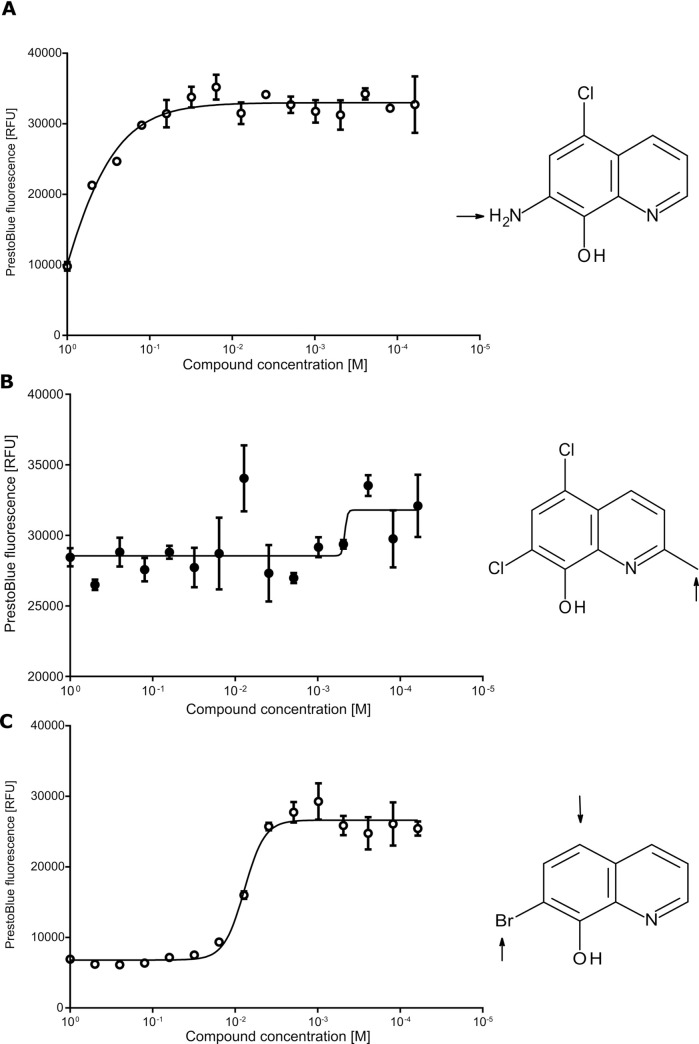
Hit expansion around chloroxine.A B. thailandensis culture was harvested and resuspended to a concentration of 8x108 CFU/mL in M9 media supplemented with 730 μM ceftazidime. This was added to a 96 well plate containing two-fold dilutions of compounds in DMSO from a starting concentration of 1 mM. Plates were incubated for 24 hours at 37°C before addition of the PrestoBlue cell viability reagent and the fluorescence read. Results show three biological replicates with error bars indicating standard deviation. These experiments are equivalent to those in Fig 3 and can be compared to chloroxine in Fig 3. 7-amino-5-chloro-8-quinolinol differs to chloroxine through substitution of an amino group for a chlorine at position 7 (A). This modification causes a significant decrease in this compound’s activity as a co-treatment with ceftazidime, with a pIC50 ≈ 3.4. 5,7-dichloro-2-methyl-8-quinolinol differs from chloroxine by addition of a methyl group in the 2-position (B). This addition abolishes this compound’s activity as a co-treatment with ceftazidime at the concentrations tested. 7-Bromo-8-quinolinol differs from chloroxine by the removal of chlorine at the 5-position, and replacement of chlorine by bromine at the 7-position (C). This compound retains activity as a co-treatment with ceftazidime that is comparable with the parent compound (pIC50 = 5.1, 5.5 for chloroxine).